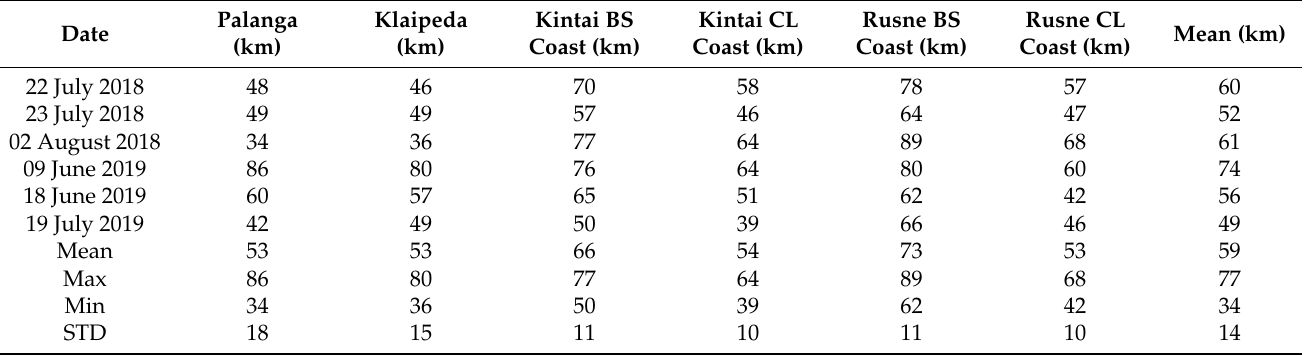
from the coast reached from 53 km to 73 km (Table 1). The farthest sea-breeze front from the coast to the continent, as much as 89 km (Table 2), was recorded on 2 August 2018 at 17:00 h (Figure 6c). However, the largest territory was covered by the marine climate on 09 June 2019, (Figure 6d), which covered 10,765.4 km 2 of the studied territory of Lithuania (Table 3). This could be due to stronger westerly winds prevailing in the second half of the day coinciding with the direction of the sea breeze and thus strengthening the penetration of the breeze and the movement of the front into the continental part of Lithuania. Table 2. Limit of maximum spread of sea breeze (km) perpendicular to the sea coastline in Lithuania) on the southeast Baltic coast (in case of maximum spread, at 17:00